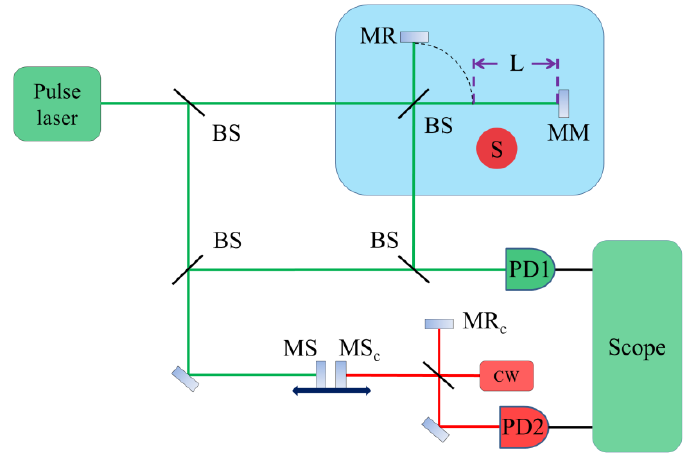
Figure 1. Experimental setup. BS: beam splitter; MR: reference mirror; MM: measurement mirror; S: sensors; PD: photodetector; MS: scanning mirror; MR c : reference mirror of the cw interferometer; MS c : scanning mirror of the cw interferometer; cw: continuous wave laser.